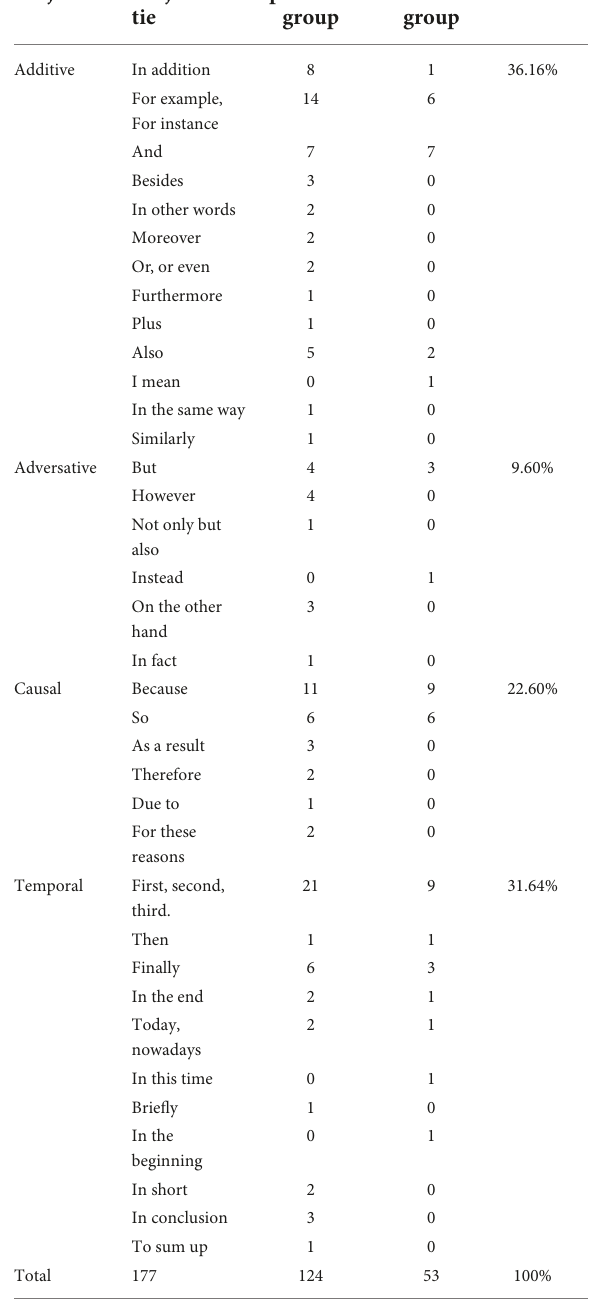
TABLE 8 Conjunctive ties used by students in their post (PWT). Table 8 indicates that for example and for instance were the most frequently used additive devices followed by in addition